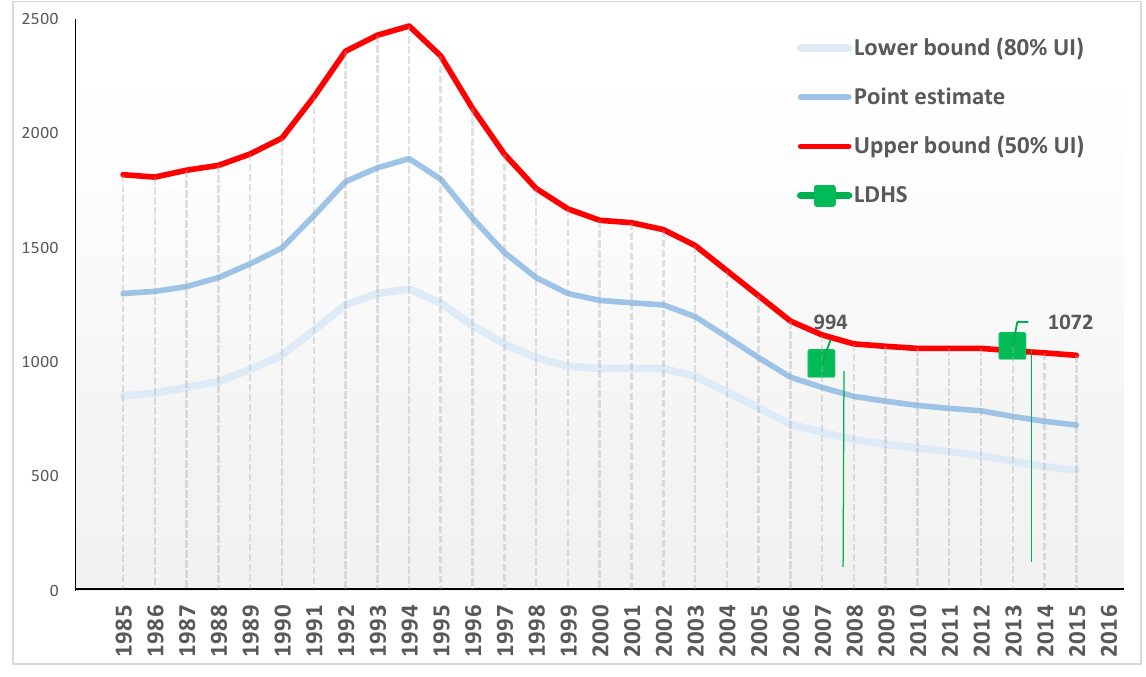
Figure 1. Maternal Mortality Ratio in Liberia